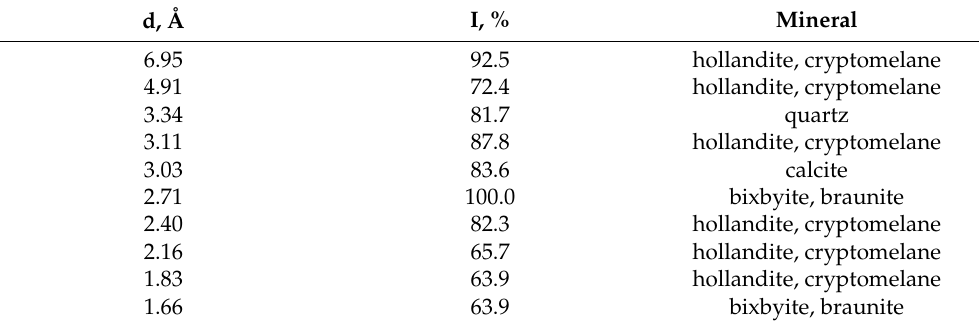
Table 4. Interplanar distances, relative intensities of reflexes, and phase content of manganese ore sample from the Bogach deposit.